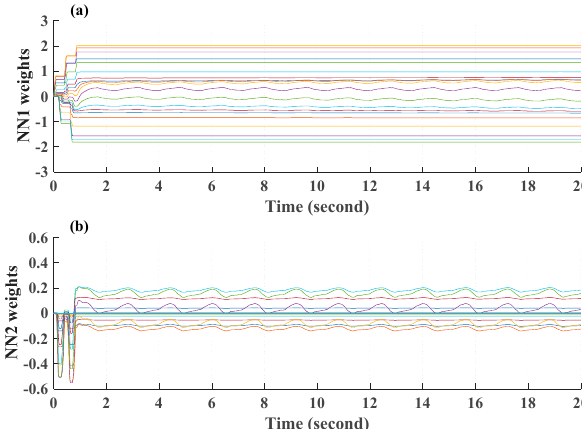
Figure 11. The convergence of weights of the approximations ( a ) in mechanical dynamics, ( b ) in hydraulic dynamics.